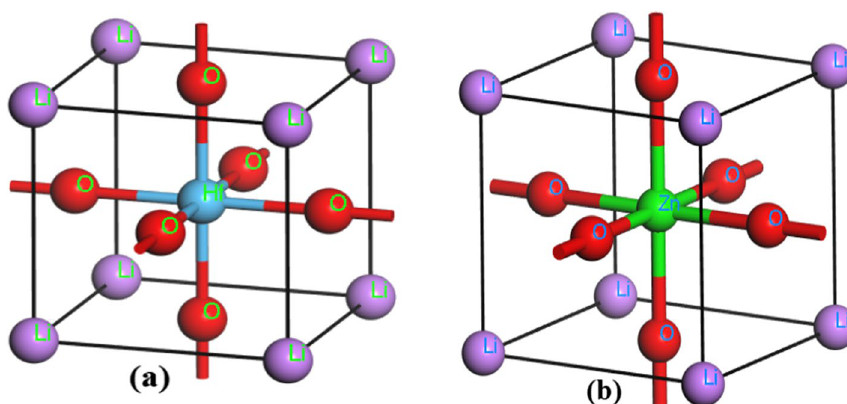
Fig. 1 Crystal Structure of a LiHfO